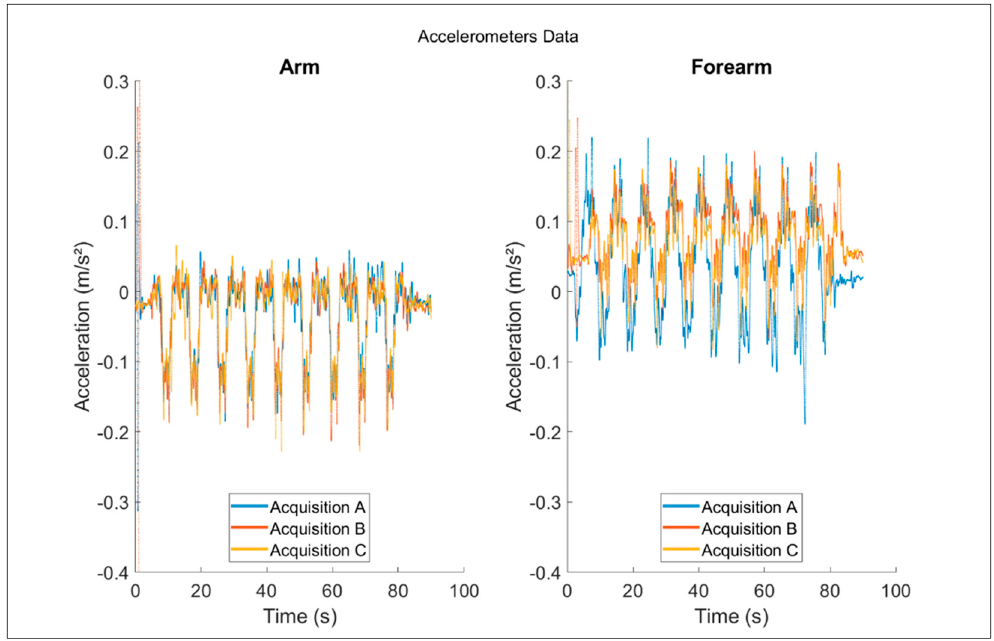
Figure 8. From the left, a acc signals of arm and forearm with respect to time. Colors refer to the acquisitions: blue for Acquisition A, red for B, and yellow for C.